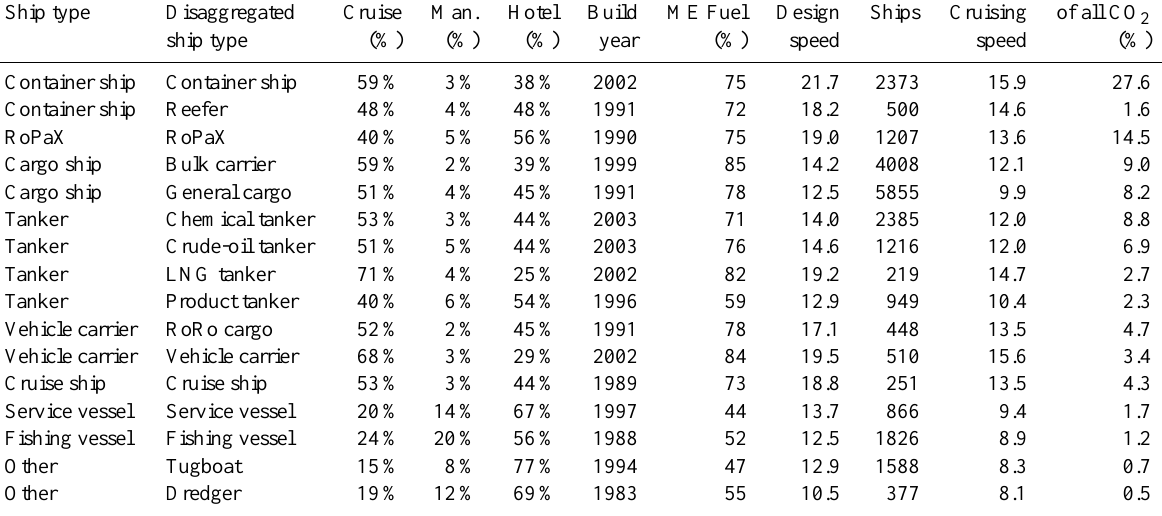
Table 3. Summary of average operational features of some selected ship types. The first column indicates the aggregated ship type, whereas the second column contains a more detailed description of vessel type. The time spent in each operation mode (cruising, maneuvering, hotelling) is indicated by the next three columns as percentages. “ME of Fuel” refers to the fraction of fuel used in main engines from total fuel consumption. Cruising speed indicates average cruising speed observed in AIS data. The last column on the right-hand side indicates the significance of contribution to overall CO 2 emissions. These ship types are responsible for over 98% of total CO 2